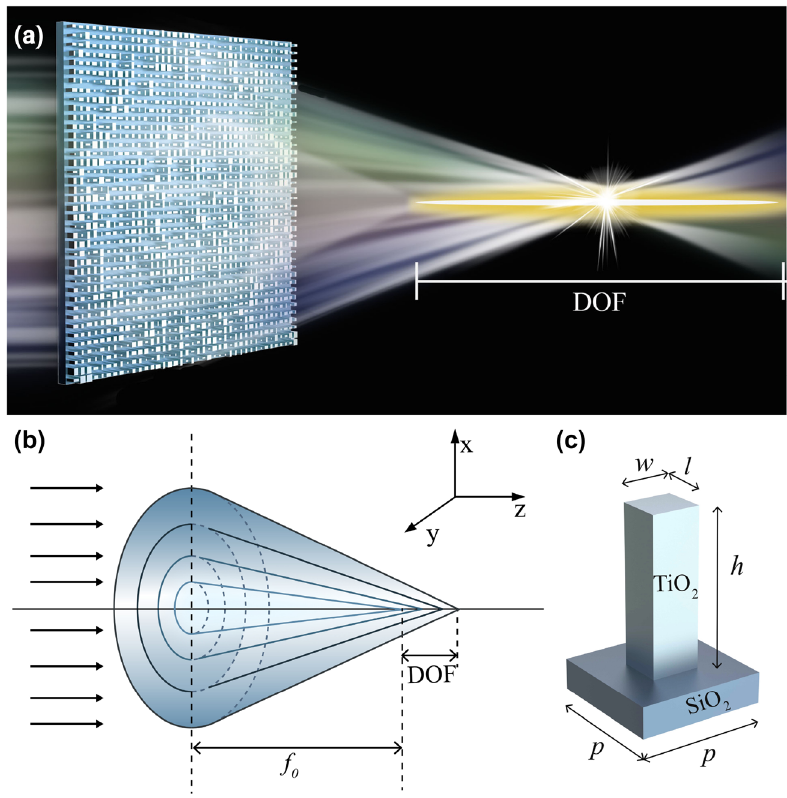
Figure 1: High-efficiency extended DOF metalens. (a) Schematic diagram of the metalens. (b) Focused optical path of the metalens with a variablefocal-lengthphase.(c)Unitstructure of